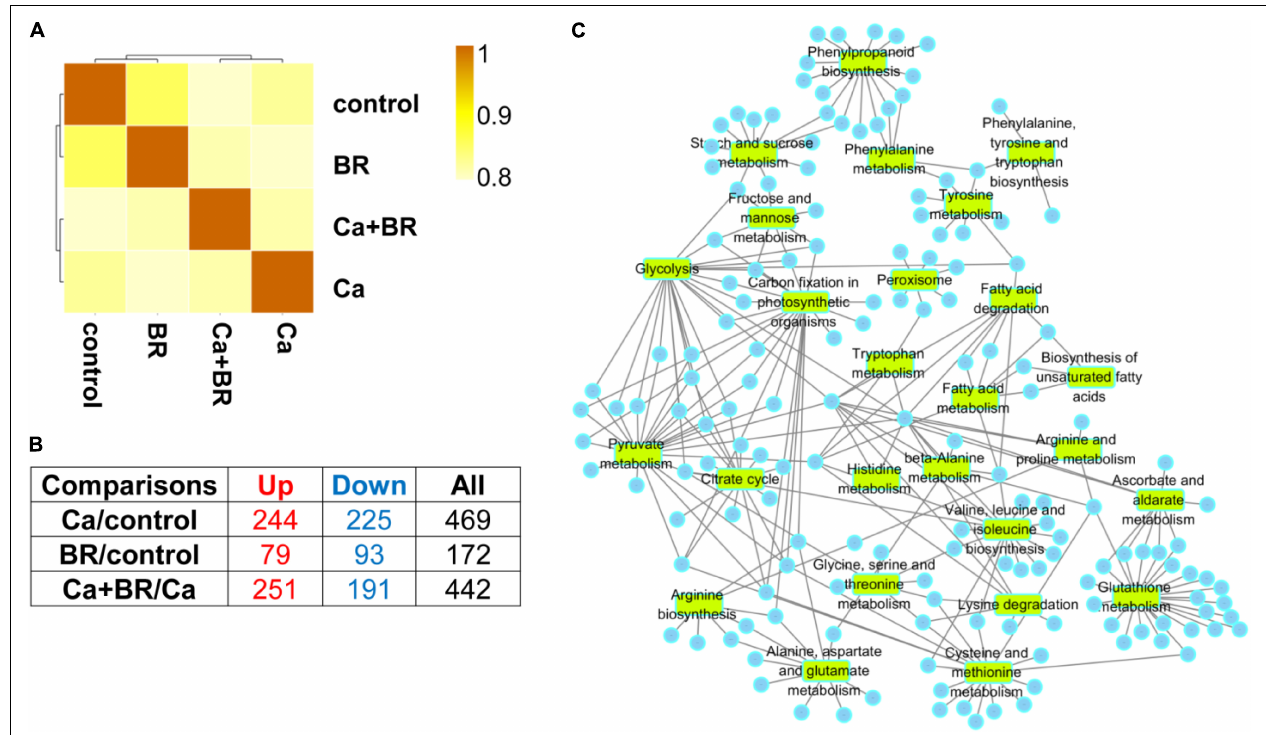
FIGURE 2 | The Spearman correlation coefficient analysis for proteomics data (A) and the number of the differentially changed proteins from the leaves of tomato seedlings subjected to 100 mmol/L of Ca(NO 3 ) 2 (Ca), foliar spraying with 0.1 µ mol/L BR, or their combinations (B) . Up, up-regulated differentially changed proteins. Down, down-regulated differentially changed proteins. (C) Selected broad Gene Ontology (GO) terms in the leaves of tomato seedlings subjected to Ca(NO 3 ) 2 stress (Ca), foliar spraying with BR, or their combinations. Circles represent the differentially changed proteins in different